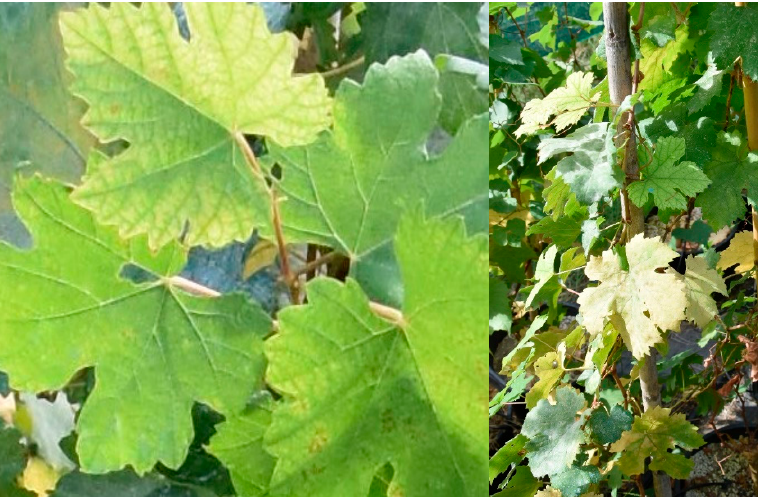
Figure 1. Cr(VI)-induced leaf chlorosis (left: first appearance in young leaves 45 days after the beginning of Cr(VI) treatment; right: overall leaf chlorosis 60 days after the beginning of Cr(VI) treatment).